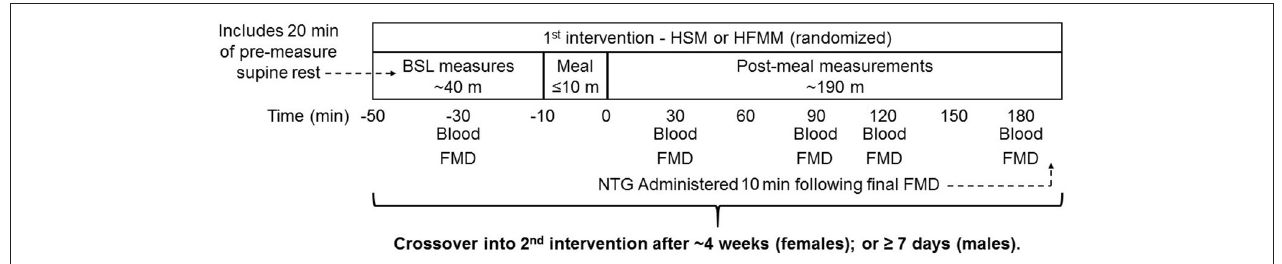
FIGURE 1 | Study design: Sedentary participants ( n = 11), runners ( n = 12), weight lifters ( n = 13), and cross-trainers ( n = 9) were screened, consented, and enrolled in the study. Subjects underwent a resting FMD and blood draw followed by a 75g glucose drink (high sugar meal; HSM) or a high fat mixed meal (HFMM) followed by repeated measures FMD and blood draws at 30, 60, 120, and 180min post-meal. Participants were instructed to drink the meals within 10min. Blood draws were taken for determination blood glucose, insulin, and triglycerides. Following ≥ 1-week washout for males and 1-month for females, the visit was repeated for the remaining meal. Meal order was randomized.